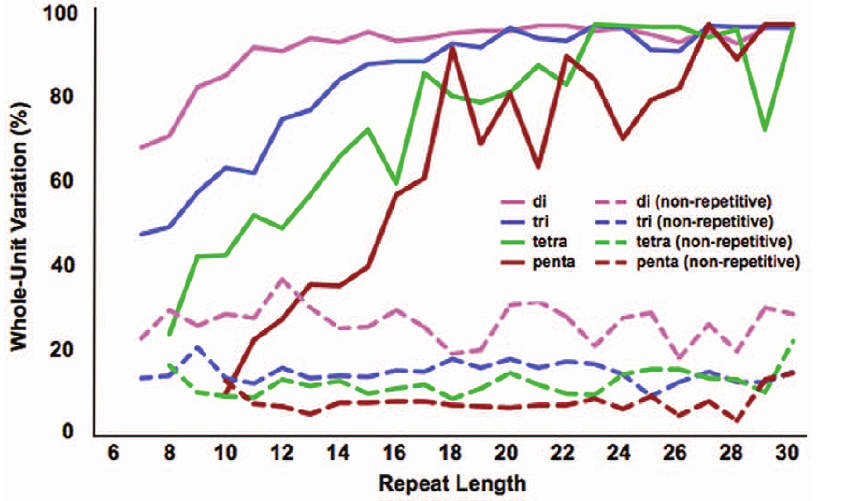
Figure 6. The tendency for differences in repeat length to occur in the form of insertions and deletions of whole repeated units increases with repeat tract length. The percent in-phase values of uninterrupted 2mer, 3mer, 4mer, and 5mer repeats approached a plateau at repeat lengths of 13, 20, 23, and 27 bases respectively, where length-changes are close to 100% in-phase. Genotypes for pure repeats were determined in all the DGRP lines if there were at least two scorable reads and a read was scored if it spanned the repeat region with 3 or more matching flank bases on either side of the repeat.